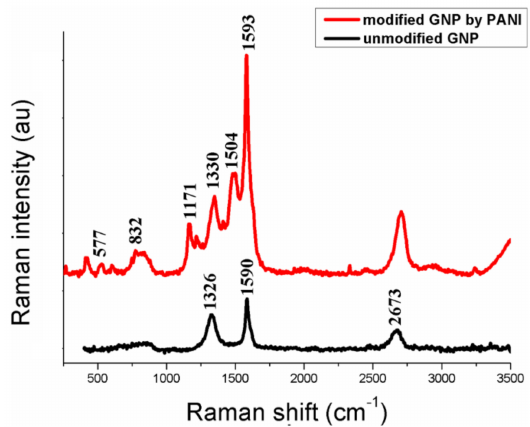
Figure 4. Raman spectra of ( a ) unmodified GNP and ( b ) modified GNP by PANI.